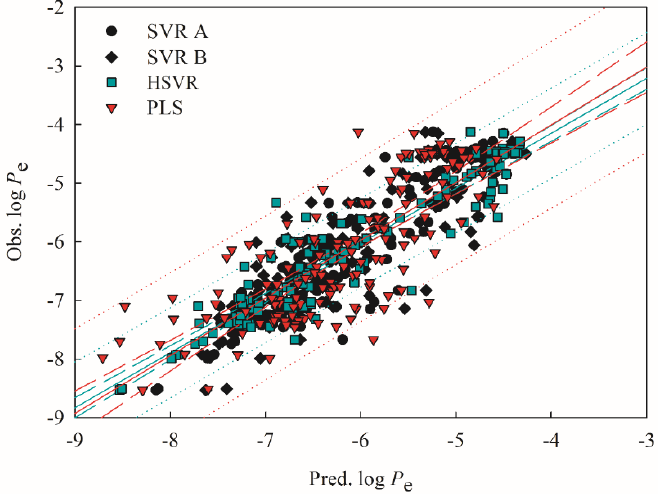
Figure 3. Observed log of the effective permeability coefficient ( P e ) vs. the log P e predicted by SVR A (solid circle), SVR B (solid diamond), hierarchical support vector regression (HSVR ; green square), and partial least square (PLS; red triangle) for the molecules in the training set. The green and red solid lines, dashed lines, and dotted lines correspond to the HSVR and PLS regressions of the data, 95% confidence intervals for the HSVR and PLS regressions, and 95% confidence intervals for the prediction, respectively.